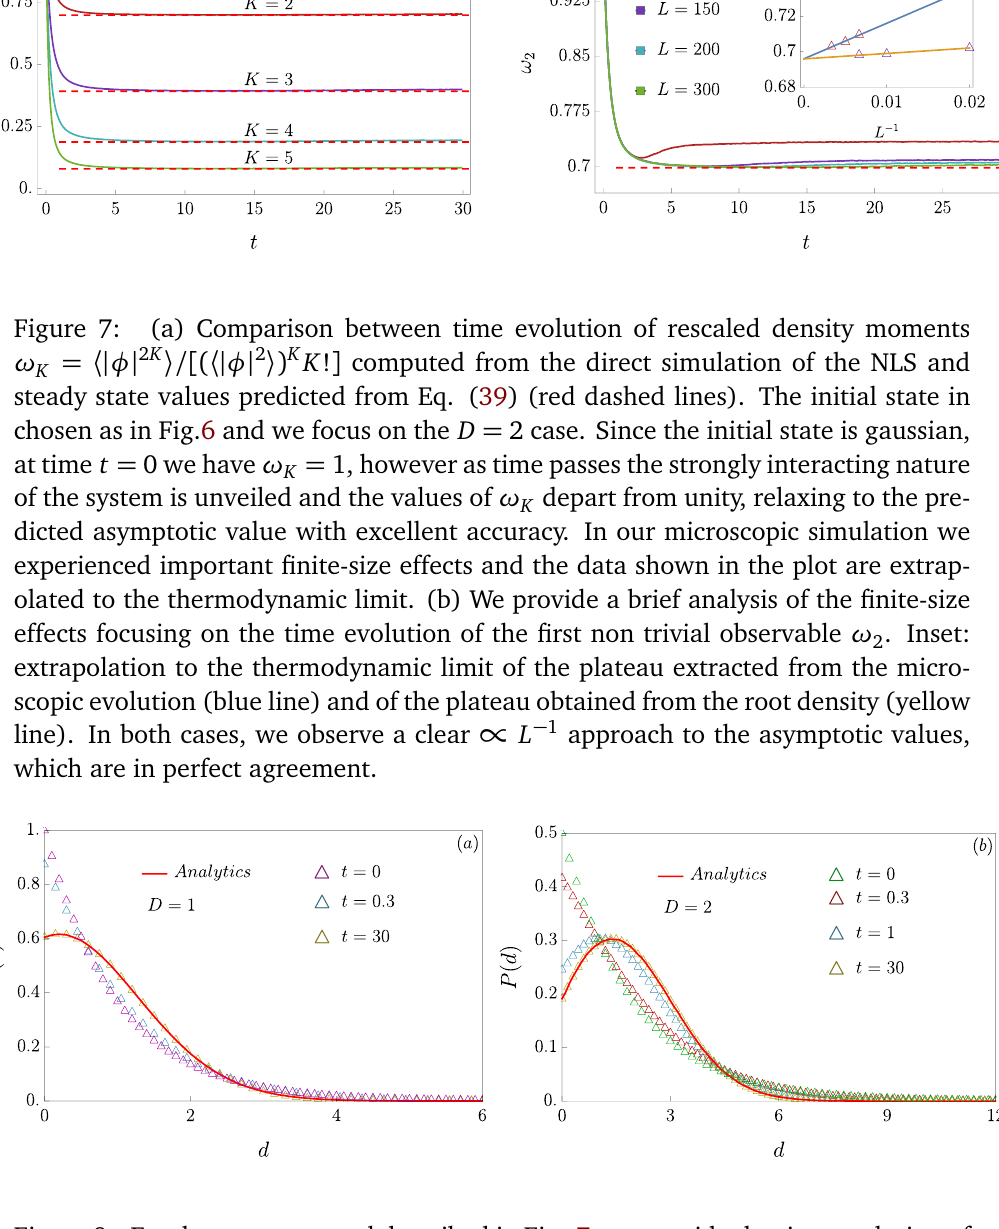
Figure 8: For the same protocol described in Fig. 7, we provide the time evolution of the FCS of the density operator. Its profile is numerically computed at different time steps and at late time clearly collapses on the analytical prediction Eq. (48), where we employed the GGE root density numerically extracted from the initial